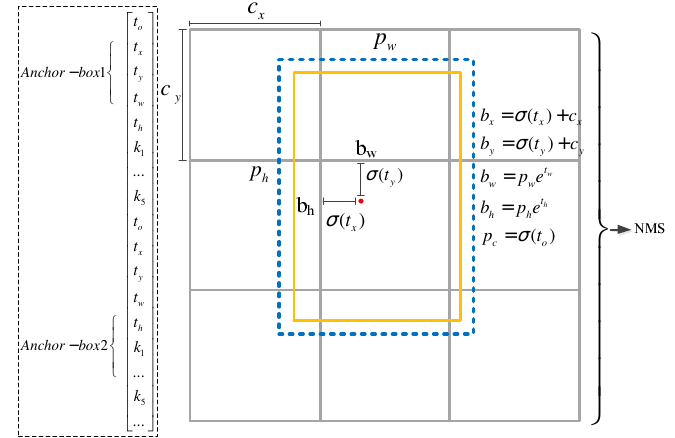
Figure 9. Bounding box coordinate transformation relation.